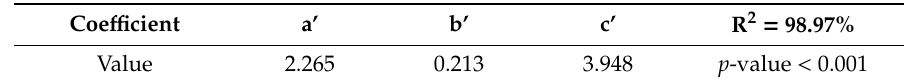
Table 4. Regression parameters of Equation (17) for the Tunnel Traveling Task. (Speed [cm / s]; A [cm]; W [cm]).